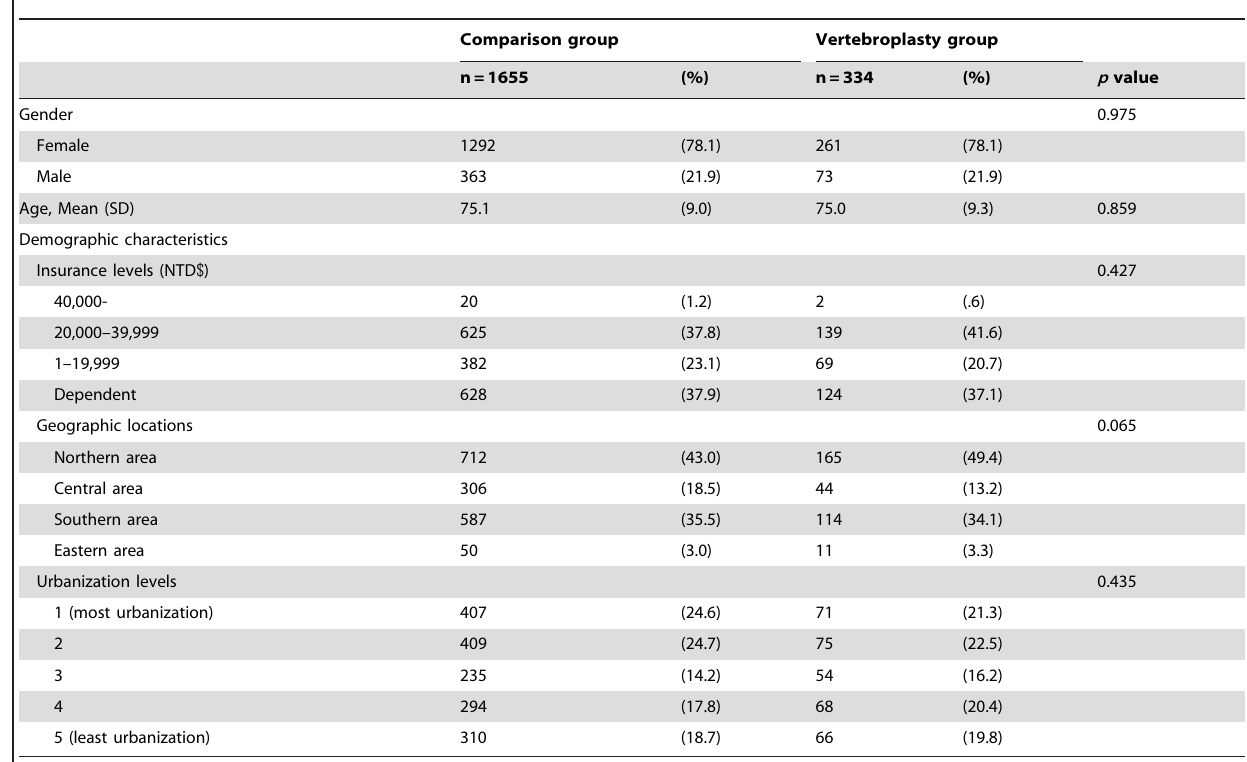
Table 1. Comparison for demographics and socio-economic status (n=